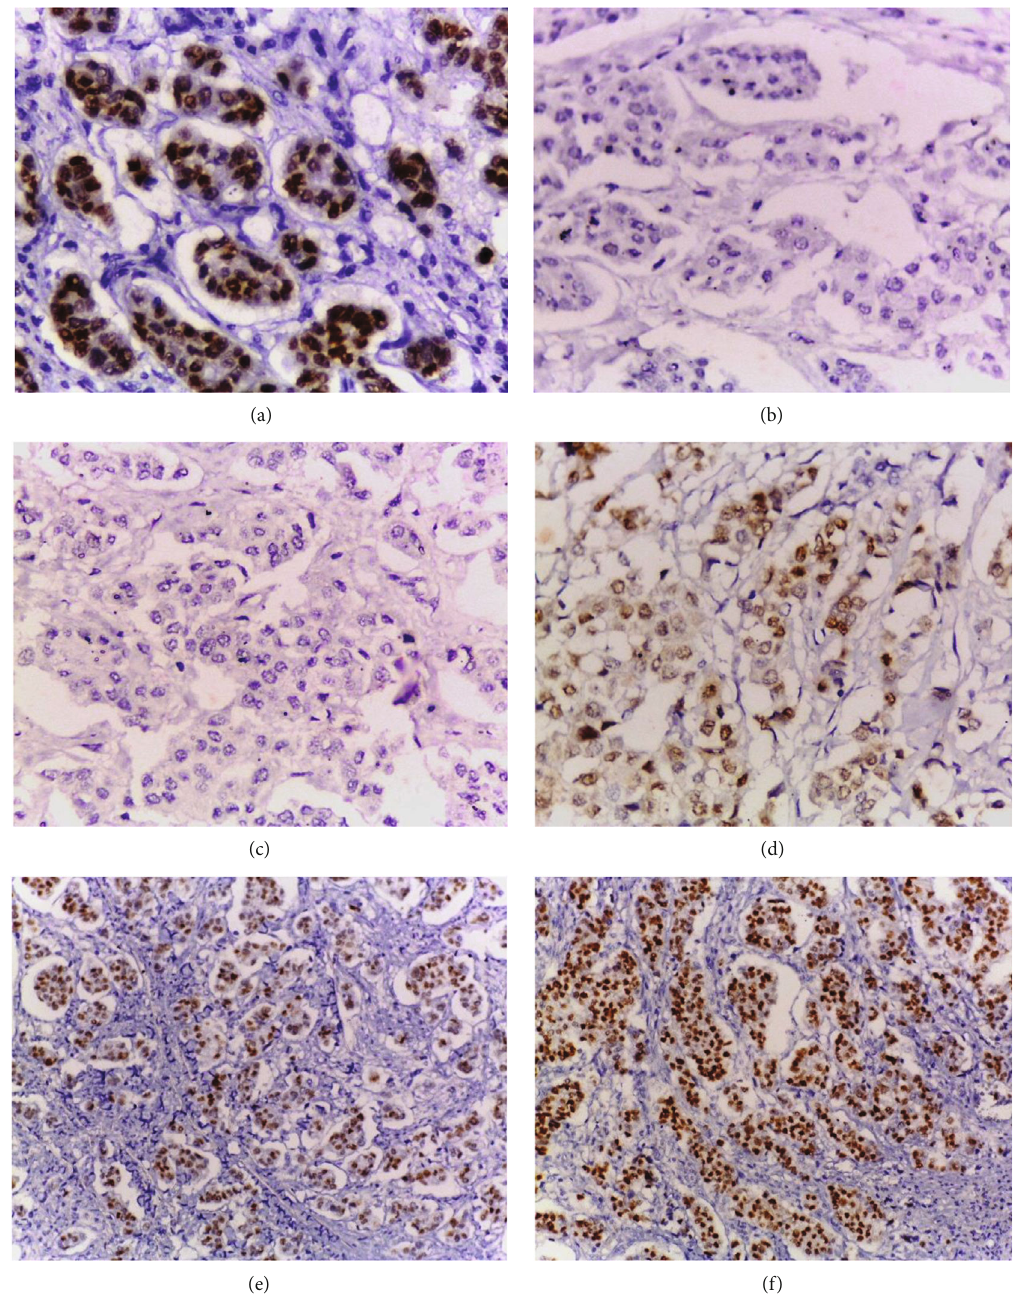
Figure 2: Representative samples of MALAT1 and BACH1 immunohistochemical expression in TNBC. (a) A case of positive MALAT1 immunoreactivity with strong nuclear expression (400x). (b) The previous case shows negative BACH1 expression. (c) A case of TNBC shows negative MALAT1 expression (400x). (d) The previous case shows positive BATCH1 immunoreactivity with moderate nuclear and cytoplasmic expression (400x). (e) A case of positive MALAT1 immunoreactivity with moderate expression (200x). (f) The previous case shows positive BATCH1 immunoreactivity with strong expression